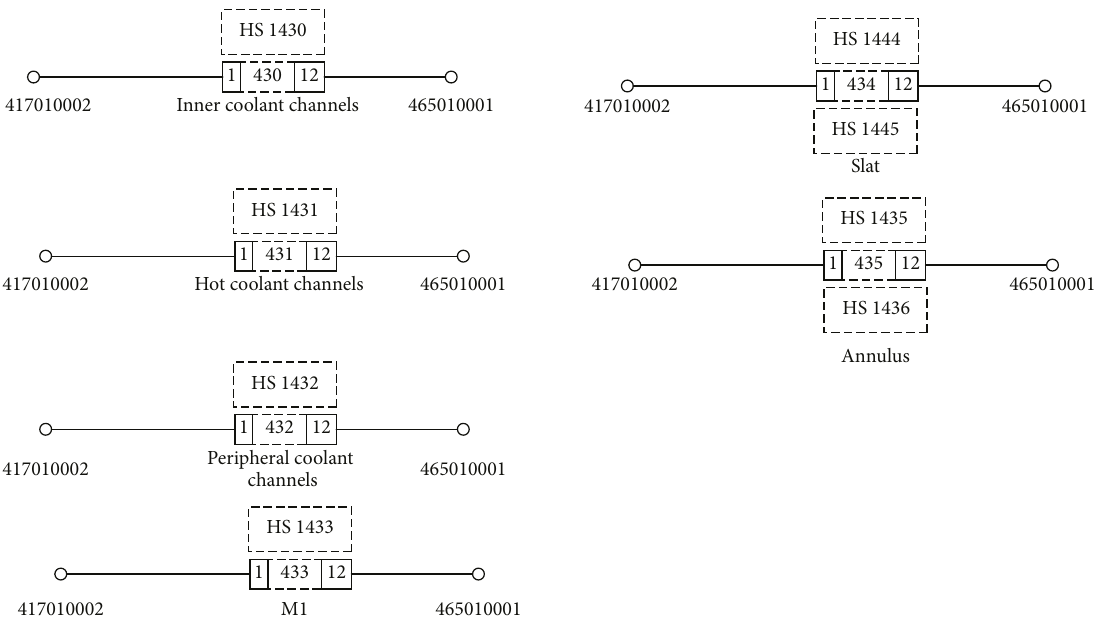
Figure 8: Pewee I detailed nodalization diagram of core